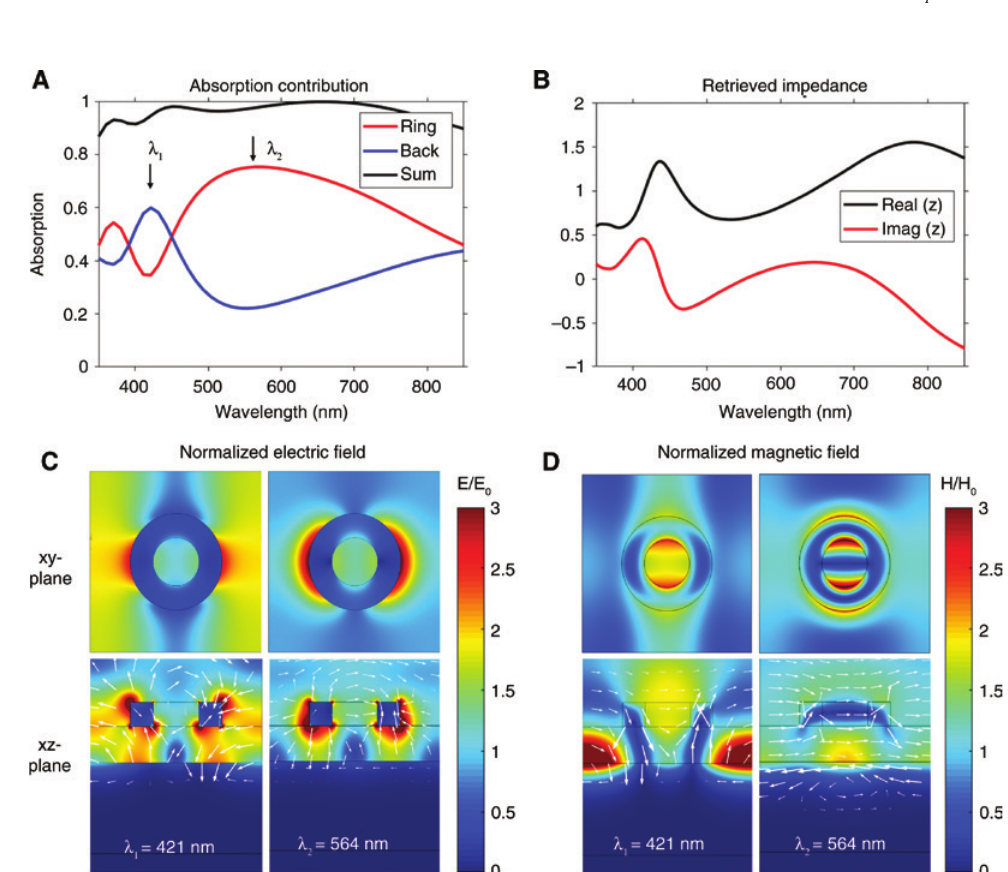
Figure 2: Full-wave electromagnetic simulations for Cr absorbers. (A) Absorption contribution of each layer. (B) Retrieved homogenous impedance of the device. (C) Calculated normalized electric field (surface plot) and electric field (arrow) along the xy-plane (first row) and xz-plane (second row). (D) Calculated normalized magnetic field (surface plot) and displacement current density